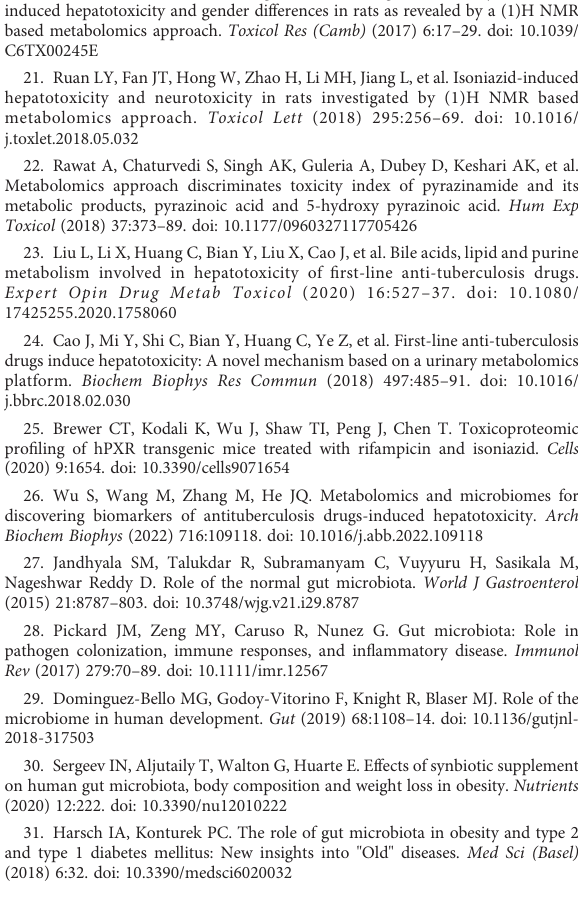
SUPPLEMENTARY FIGURE 3 Principal co-ordinates analysis. SUPPLEMENTARY FIGURE 4 Subgroup analysis of 16S sequencing data of urine samples. (A) Venn diagram. The left is the severe DILI group, the right is the non-DILI group. (B) Difference comparison of the top 10 key species. (C) LEfSe analysis. Species with LDA greater than the set value of 2 are presented. The length of the bar indicates the magnitude of LDA in fl uence. SUPPLEMENTARY FIGURE 5 Cross validation curve. The abscissa is the number of variables, and the ordinate is the cross-validation error